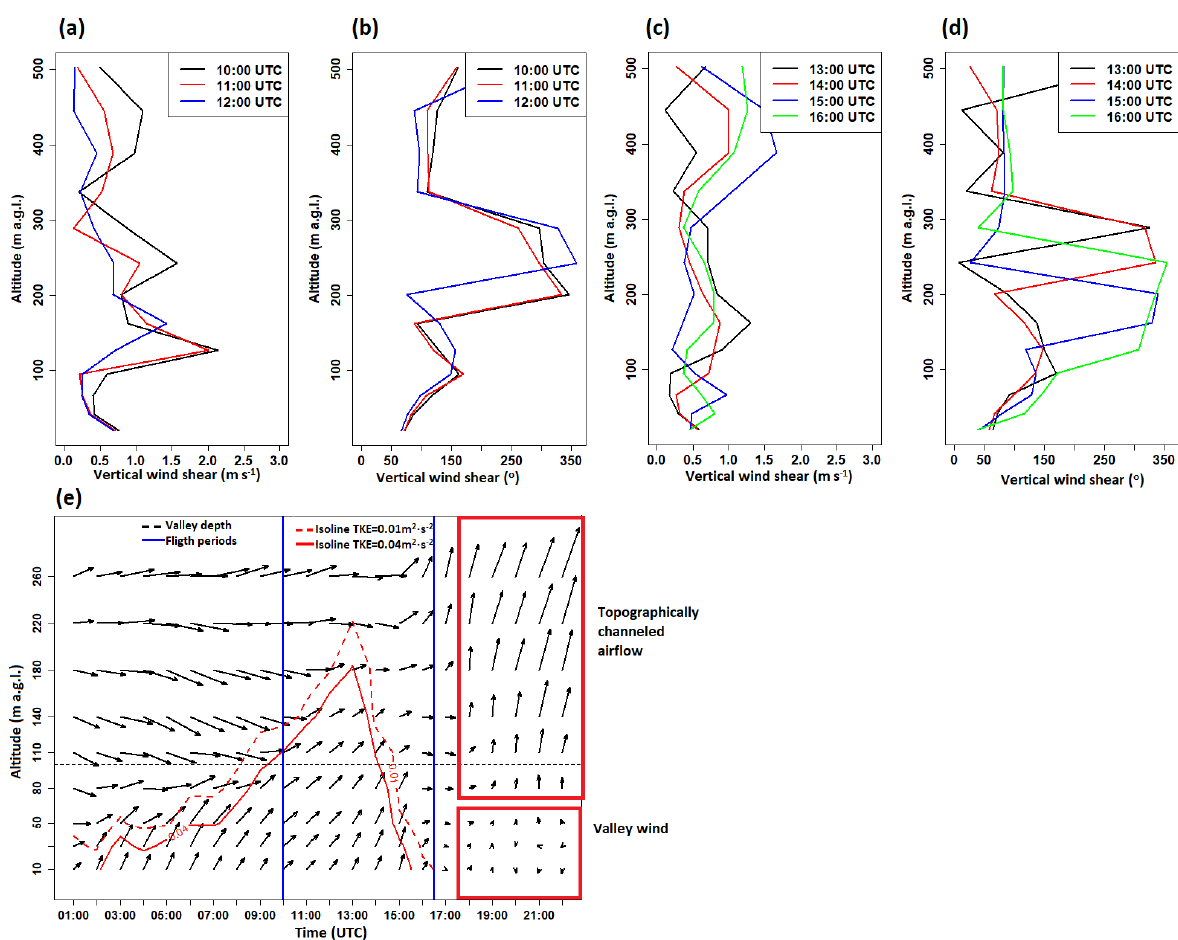
Figure 8. Vertical profiles of wind shear between 10:00 and 16:00UTC, 27 January 2020: wind shear speed (a, c) and direction (b, d) . Wind profile forecast with added isolines of TKE equal to 0.01 and 0.04m 2 s − 2 for the point representing the city centre. Measurement period is marked with blue vertical lines. Explanation: valley depth is the altitude of the hilltops surrounding the valley marked at 100ma.g.l. with a dashed line in (e)